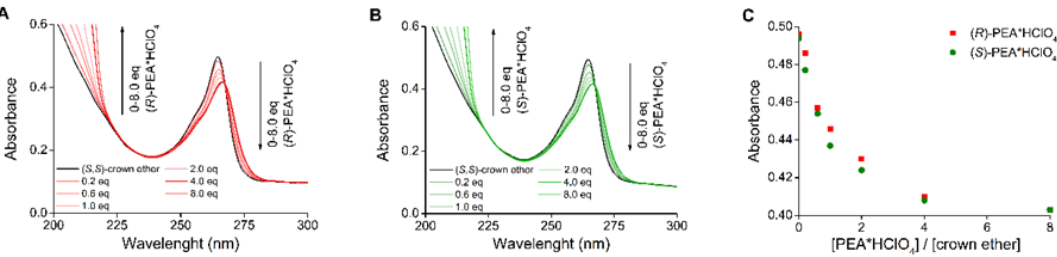
Figure 7. The UV absorbance changes of the crown ether ( S , S )- 2 in the presence of PEA ( 22 ) enantiomers ( A , B ) and the titration curves ( C ).